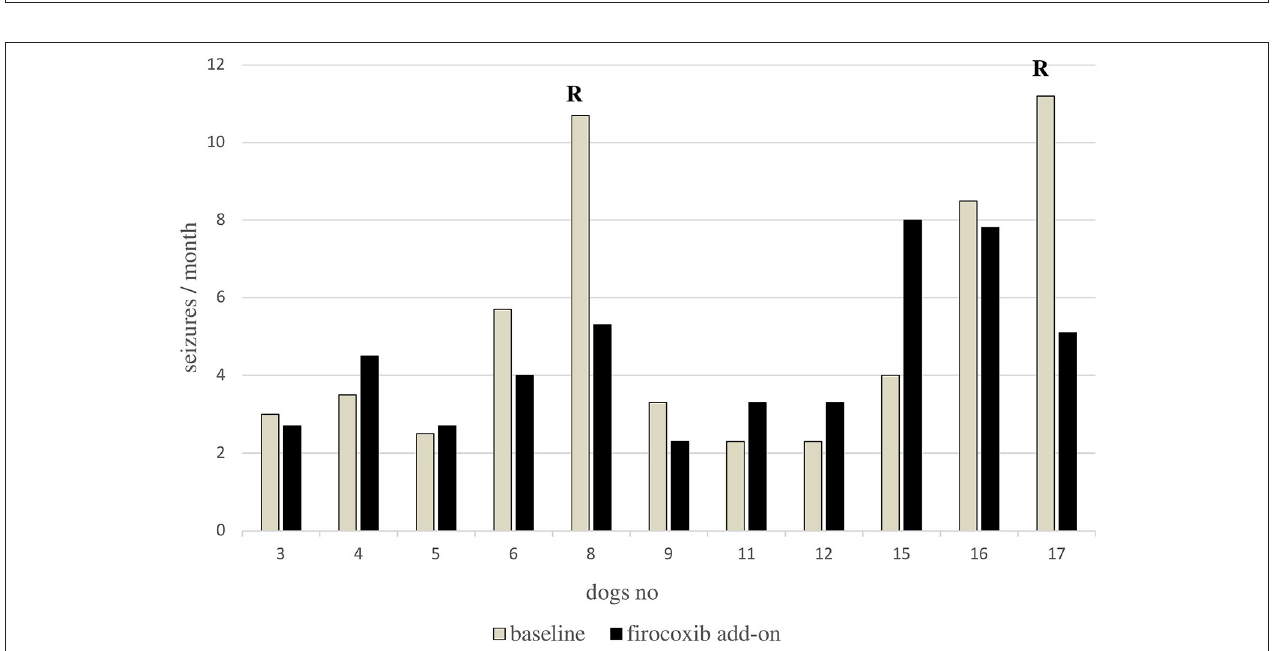
FIGURE 3 | Bar graph showing the individual monthly seizure frequency at baseline and during firocoxib add-on treatment. Six dogs showed a decrease in seizure frequency and five dogs showed an increase in seizure frequency. Only two dogs (cases 008,017) were classified as responders (R) defined by a seizure frequency reduction of ≥ 50%. None of the dogs became